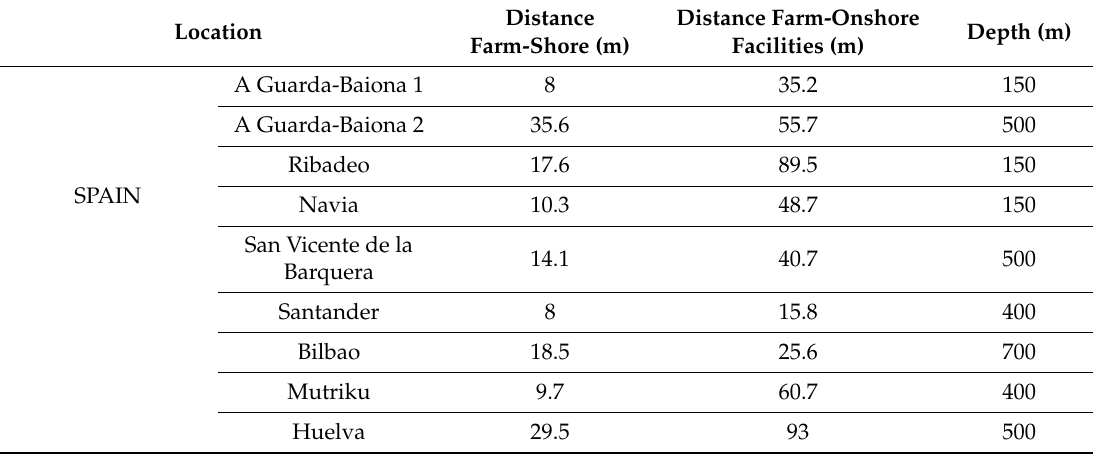
Table 4. Main characteristics of the locations